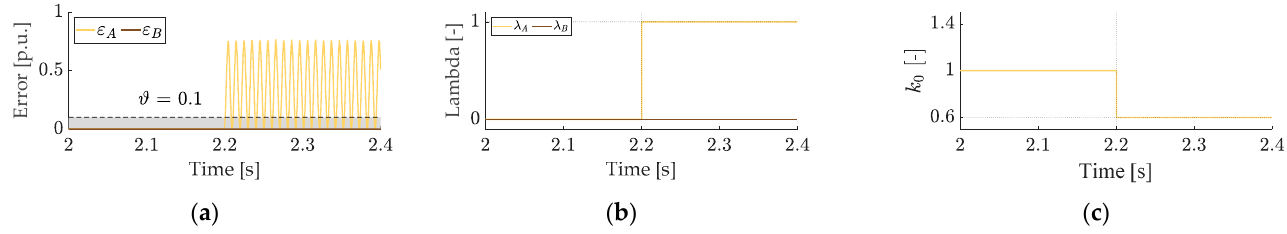
Figure 15. Measured ( a ) and estimated ( b ) stator currents in phases A and B . Figure 16. CS fault detection ( a ), localization ( b ), and change in k 0 coefficient in G matrix ( c ).